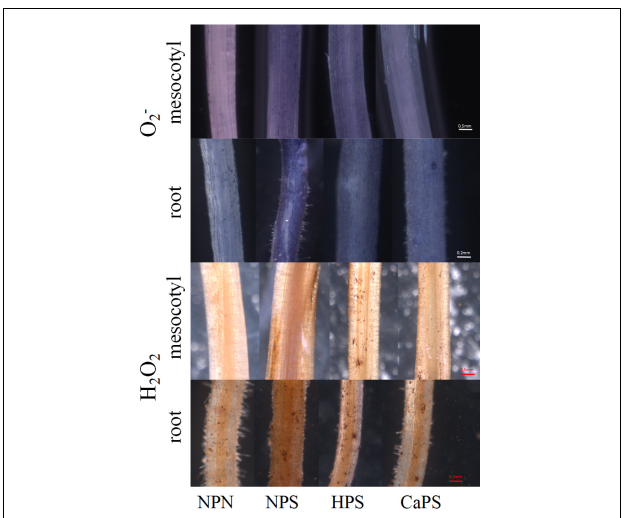
FIGURE 5 | Staining of ROS in sorghum mesocotyl and